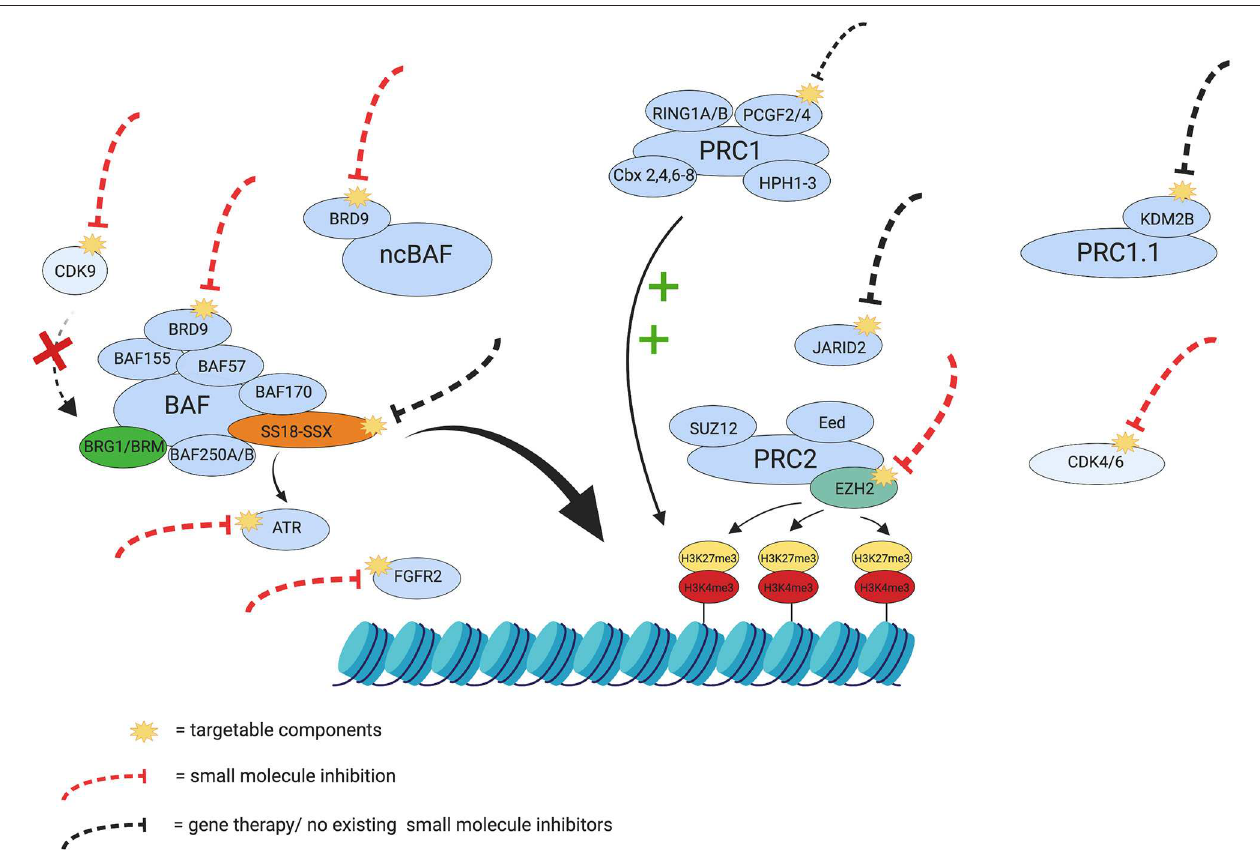
FIGURE 2 | Therapeutic targets in Synovial Sarcoma. The yellow visuals represent the potentially targetable components discussed in this review. The red dashed lines indicate components in SS that already have small molecule inhibitors and the black dashed lines indicate potential targets that currently have no small molecule inhibitor or gene therapy. Certain targets in the figure (e.g., ATR and FGFR2) have been inhibited in other cancers and have shown potential synthetic lethality and growth reduction in SS, respectively, and have therefore been included for consideration as targets. The green plus signs indicate the maintenance of the repressive tri-methylation of H3K27, exerted by PRC1, and the red cross depicts the inhibition of BRG1 through dephosphorylation, should there be inhibition of CDK9. The figure also represents some of the interplay in SS that controls chromatin remodeling and silencing and emphasizes the need for a multifactorial approach to treatment and overcome potential treatment resistance. Created with